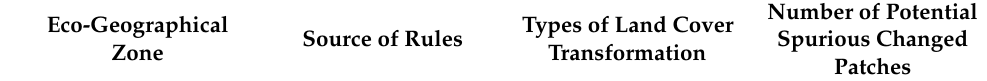
Table 8. Statistics of potential spurious changes in land